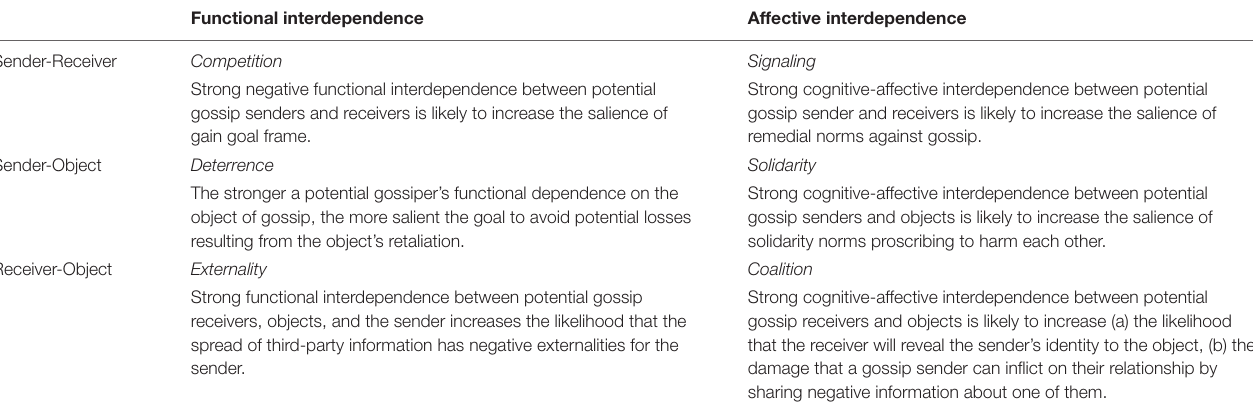
TABLE 1 | Six gossip inhibiting conditions based on Goal Framing Theory. Functional interdependence Affective interdependence